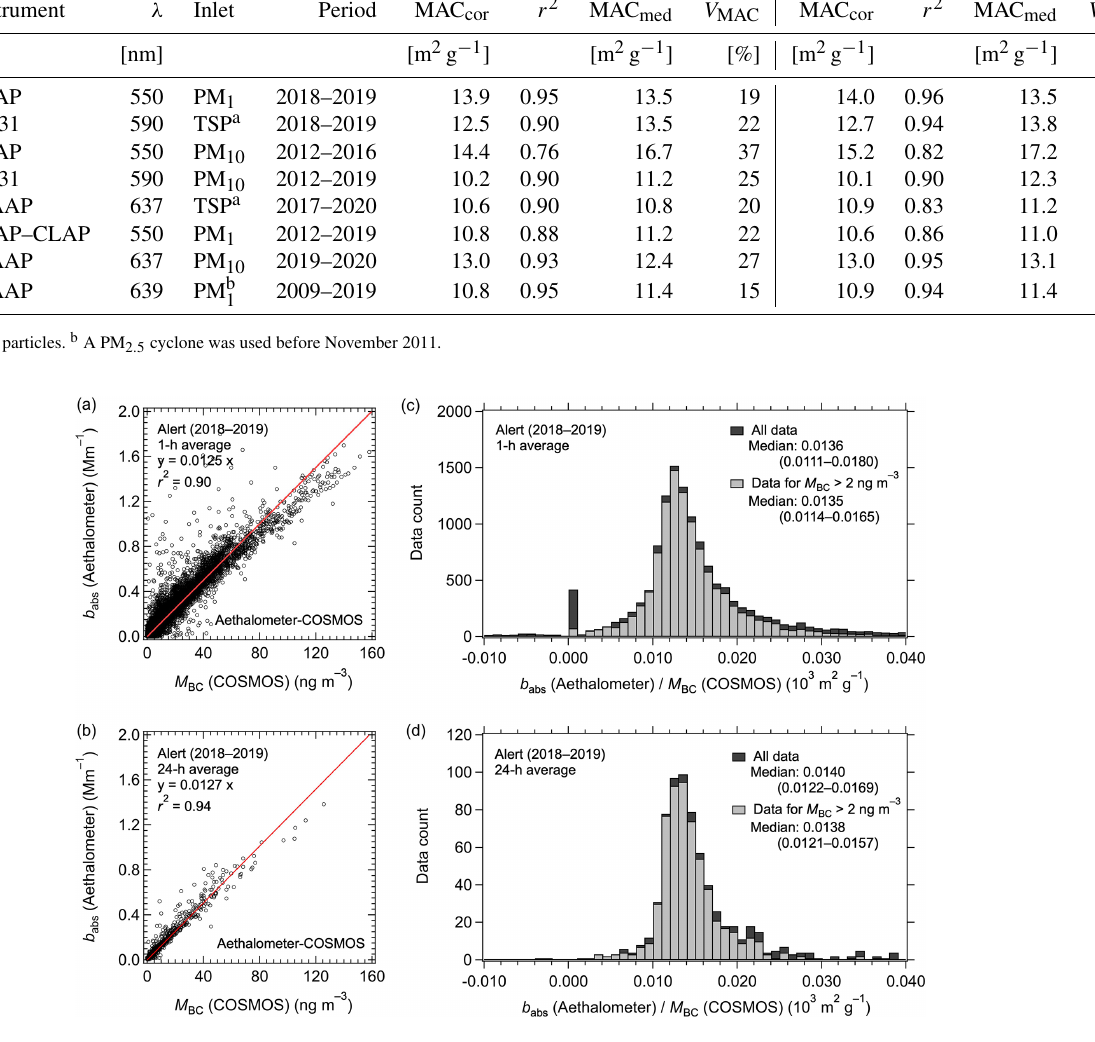
Figure 5. Correlations of M BC (COSMOS) and b abs (Aethalometer; λ = 590nm) from January 2018 to December 2019 at Alert for (a) 1h averaged and (b) 24h averaged data. The solid red lines are the least-squares regressions forced through the origin. (c, d) Corresponding histograms of b abs (Aethalometer) /M BC (COSMOS) ratios for all data and data with M BC (COSMOS) > 2ngm − 3